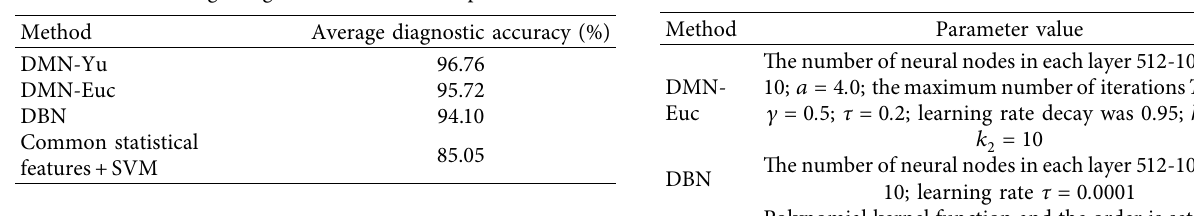
Figure 8: Confusion matrix of fault recognition for the rolling bearing test set based on DMN-Yu model. Table 2: Average diagnosis results of 10 experiments. Table 3: Parameter settings of several